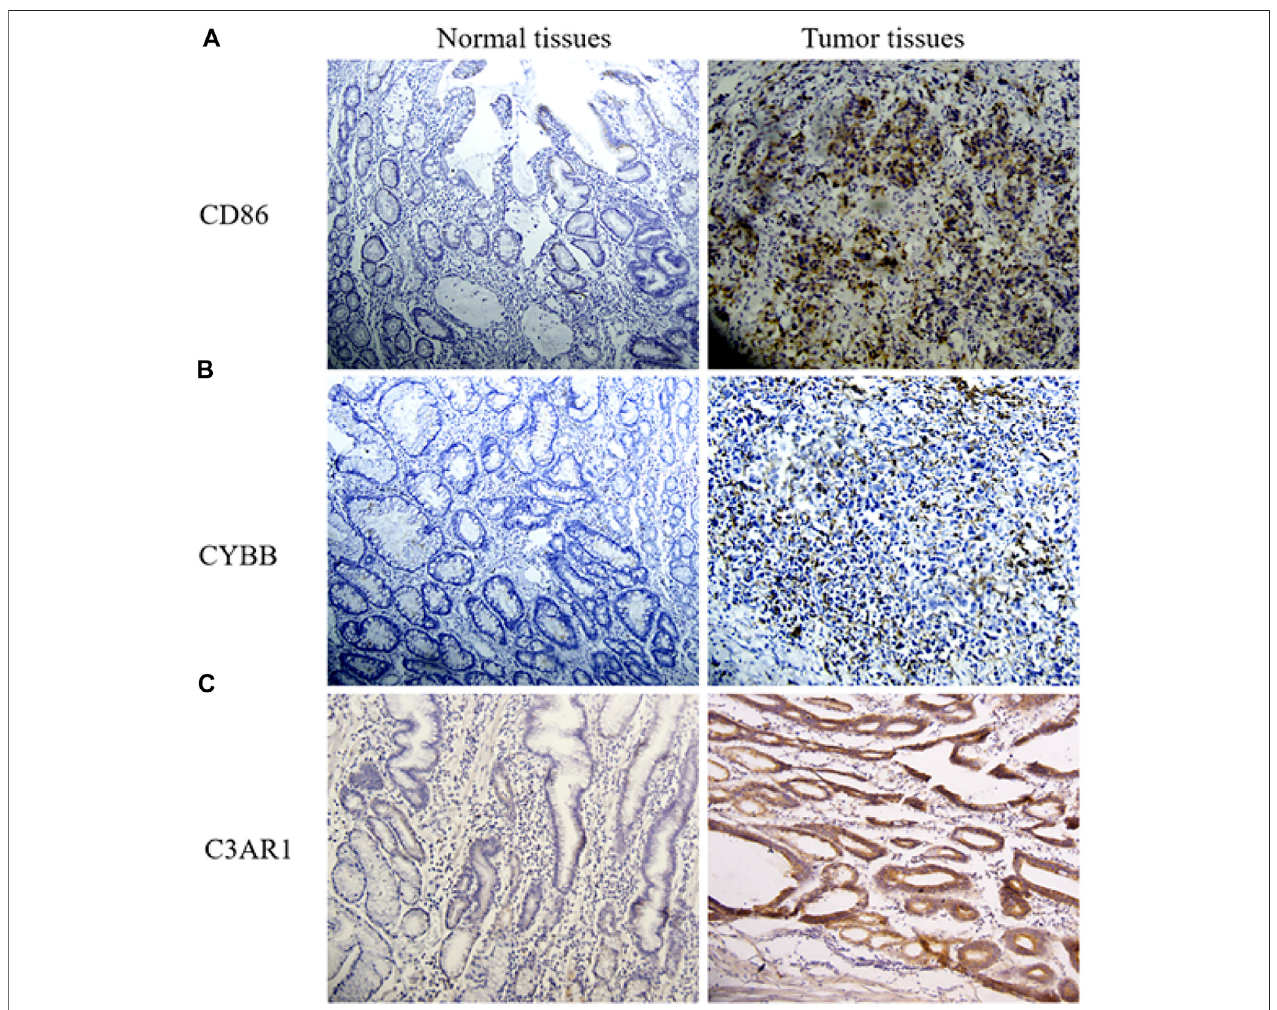
FIGURE 6 | IHC of CD86, CYBB, and C3AR1 in GC and normal tissues. (A) The expression level of CD86 in normal and GC tissues. (B) Images of CYBB IHC (Original magni fi cation, × 20). (C) IHC for C3AR1.